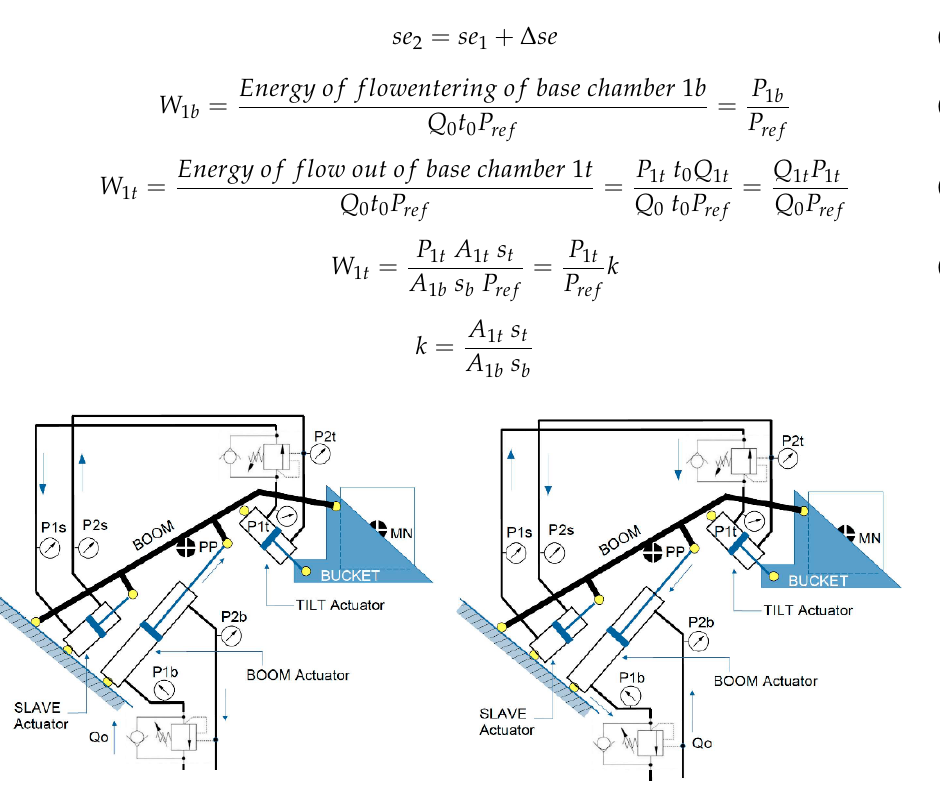
Figure 1. Scheme of a typical loader. ( Left ): upwards movement. ( Right ): downwards movement.